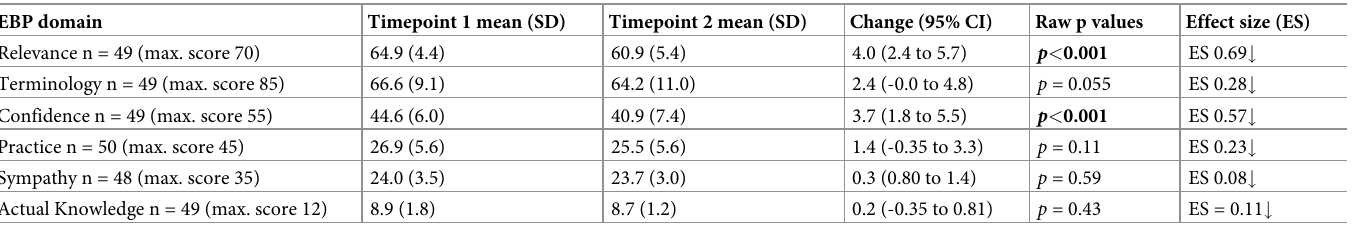
Table 1. EBP domain scores, change, p values and effect sizes for participants at completion of entry level training and after one year in the workforce (n = 50) �